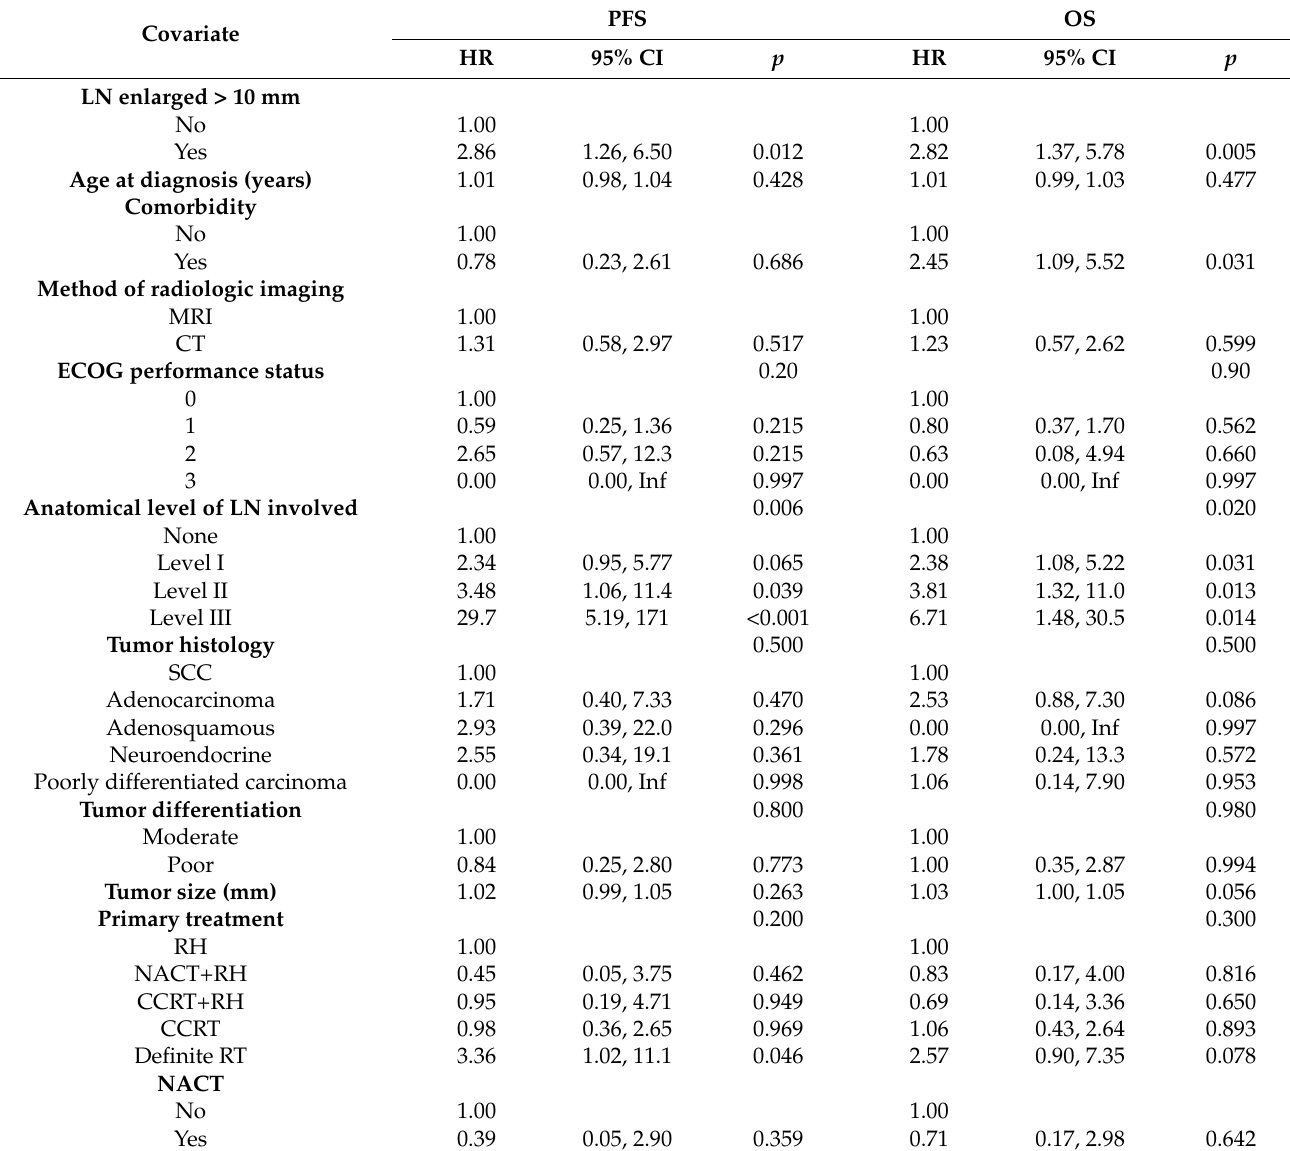
Table 2. Univariate Cox analysis of PFS and